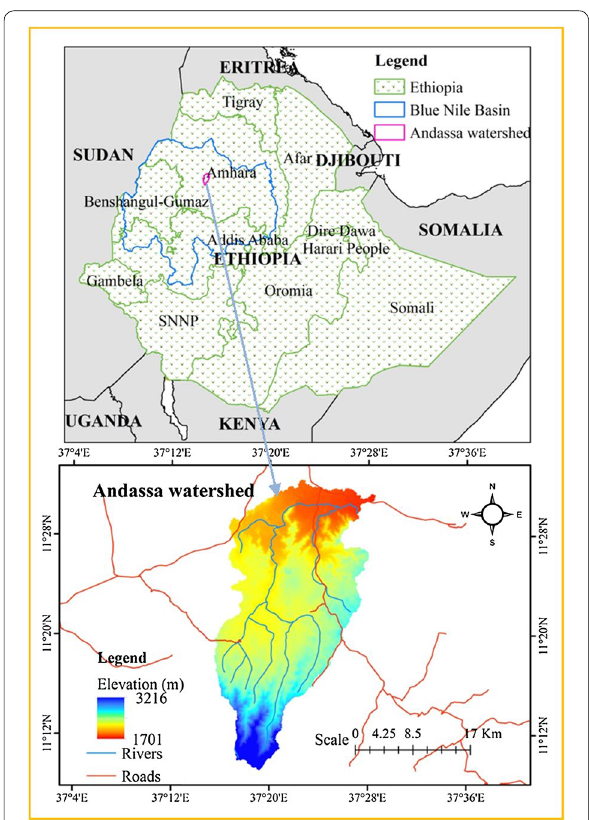
Fig. 1 Location map of the Andassa watershed in the Blue Nile basin from